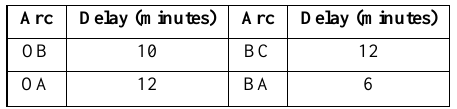
Table 2. Delay time for